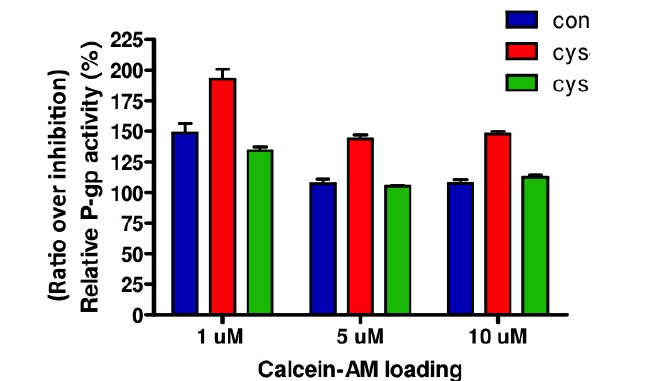
Figure 3. Relative P-gp activity after calcein-AM loading. P-gp activity in two different cystinotic (red and green bar) and one control (blue bar) ciPTEC line was determined after loading the cells with calcein-AM for 60 min (in triplicate) either in the presence of the P-gp inhibitory compound PSC833 (5 μ M) or vehicle (0.1% DMSO). Relative P-gp activity is depicted as ratio of P-gp inhibition (PSC833) over the control condition (vehicle). Ratio > 100% indicates inhibition of P-gp activity. Con = control ciPTEC; Cys = cystinotic ciPTEC.